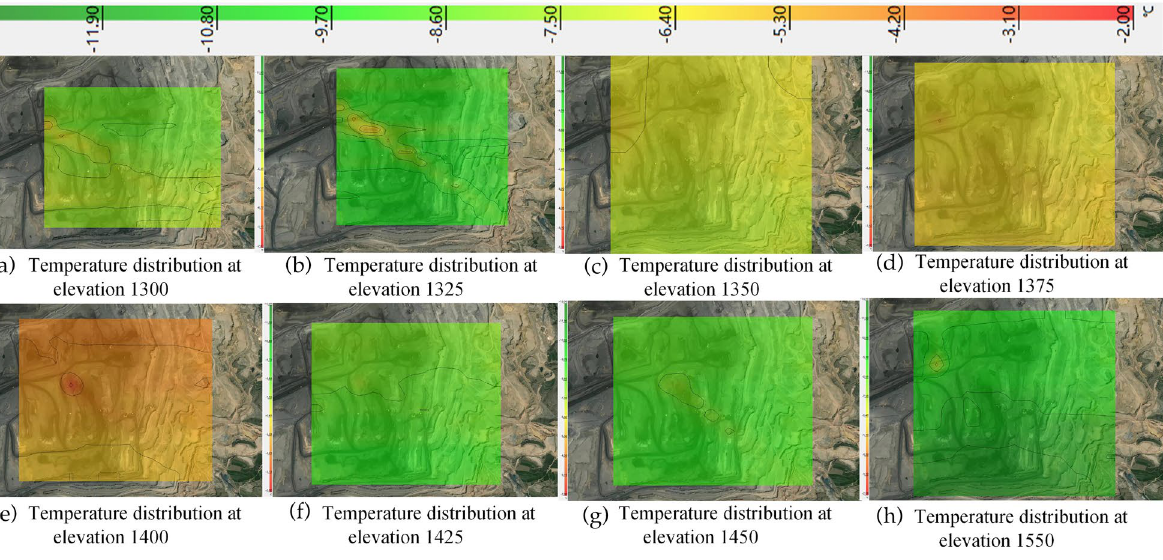
Figure 8. Temperature distribution from 1300 to 1550 elevation in